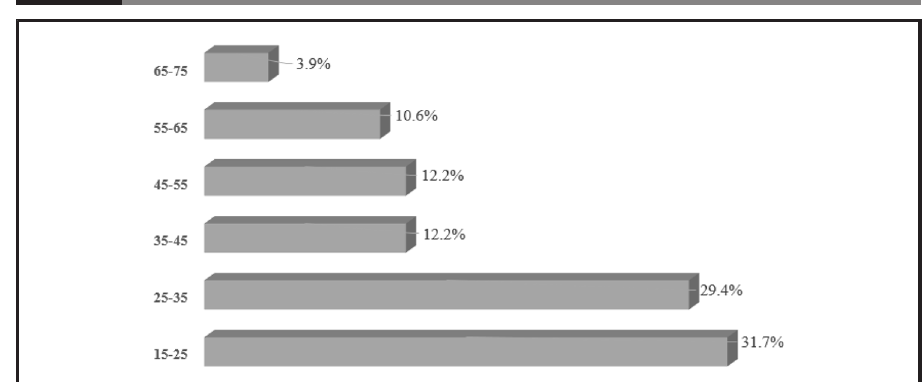
Figure 2 Chart of the age of